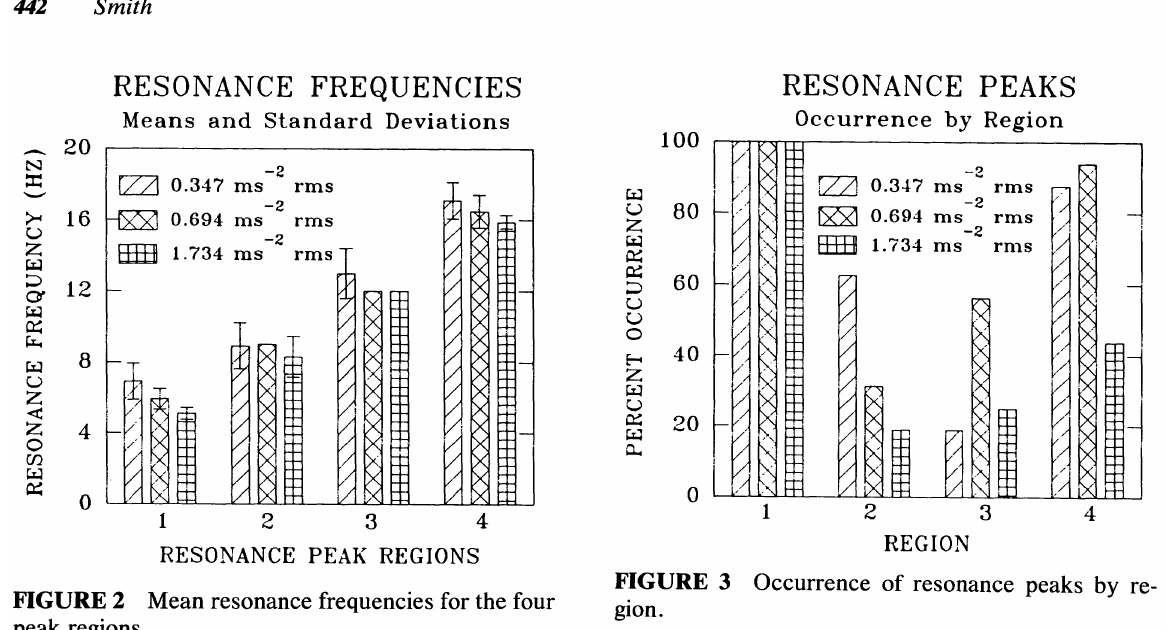
FIGURE 2 Mean resonance frequencies for the four peak regions.